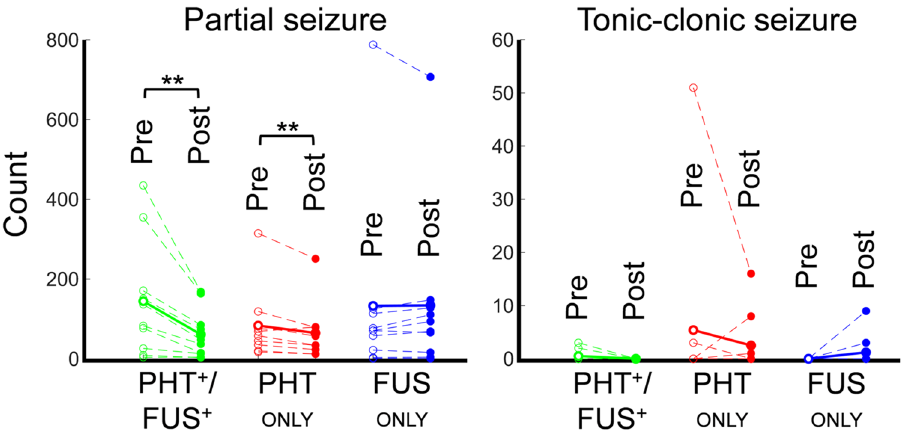
Figure 6. Changes of behavioral seizure activities based on the modified Racine’s scale. The number of partial and tonic–clonic seizure events appeared during pre- (empty circles) and post- (filled circles) intervention periods from PHT + /FUS + (green), PHT ONLY (red) and FUS ONLY (blue) groups (n = 10 rats/group). The dashed lines link the pre- and post-intervention values from each individual rat, and the solid lines link the mean values of the pre-/post-intervention ictal counts within each group. In the right panel, the data from mTLE rats that did not show tonic–clonic seizures are overlapped as a single dashed line on the x-axis for each experimental group, respectively. ** p < 0.01 (paired t -test,